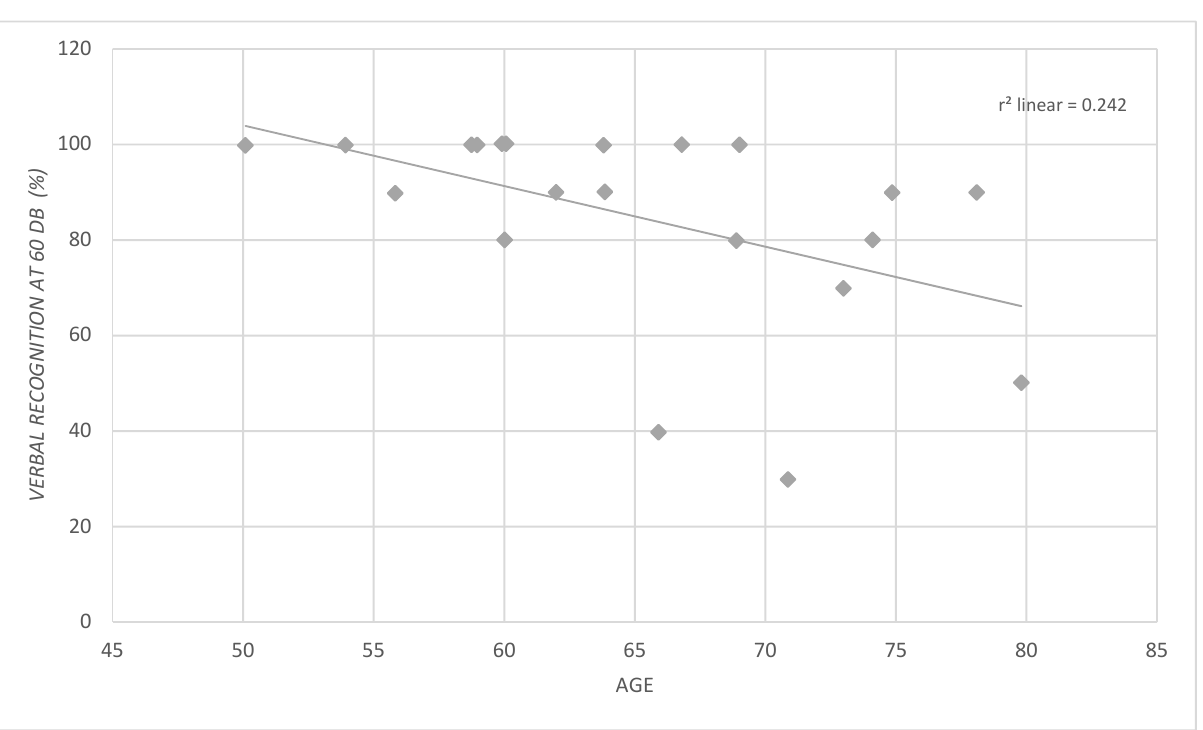
Figure 1. Scatter plot showing the significant correlation between age and verbal recognition at 60 dB after one year from the cochlear implantation.